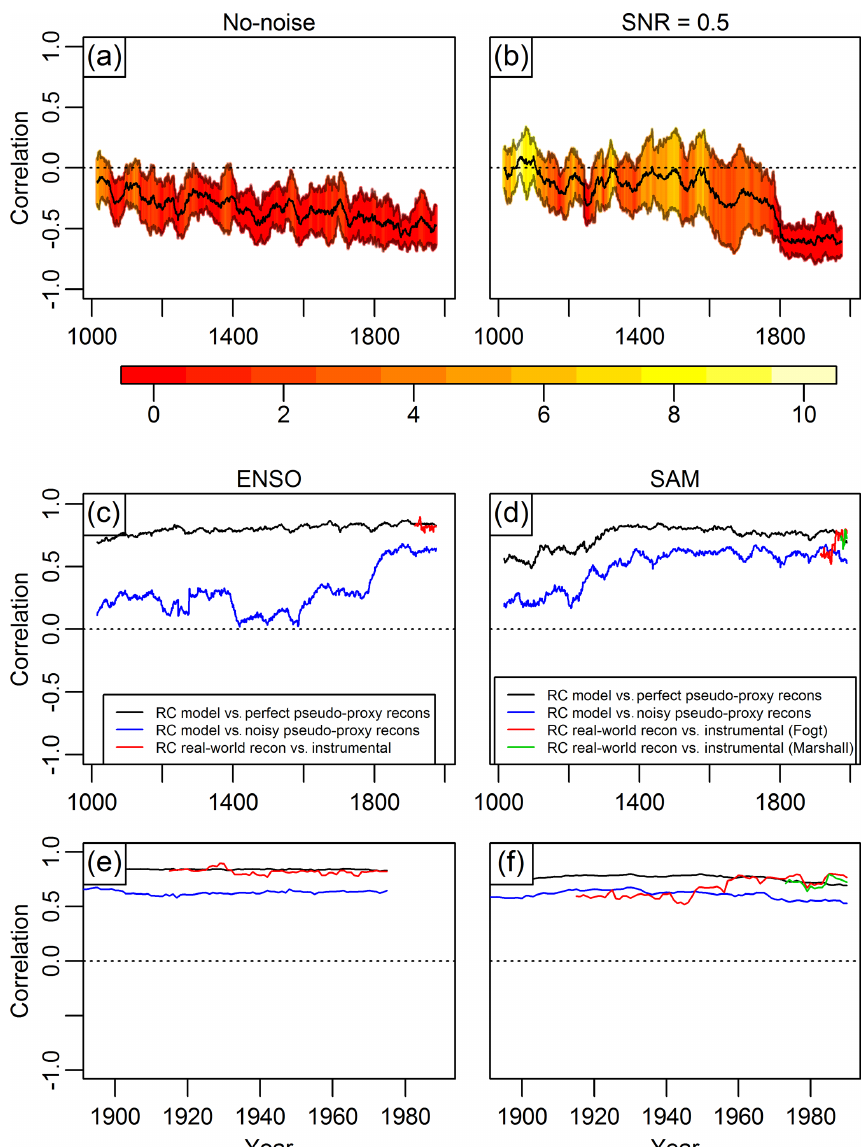
Figure 3. Panel (a) shows the mean of the 31-year running correlations over all 13 models between the perfect pseudo-proxy-based ENSO and SAM reconstructions. Panel (b) shows the same as panel (a) but using the noisy pseudo-proxy-based ENSO and SAM reconstructions. The grey lines correspond to ± 1 standard deviation. Panel (c) displays in black (blue) the mean 31-year running correlations over the 13 models between the model ENSO index and the perfect (noisy) pseudo-proxy-based ENSO reconstructions. The red line shows the 31-year running correlations between the real-world proxy-records-based ENSO reconstruction and the instrumental ENSO index. Panel (d) is the analogue of panel (c) but for the SAM. The red (green) line displays the 31-year running correlations between the real-world proxy-records- based SAM reconstruction and the instrumental Fogt (Marshall) SAM index. Panels (e) and (f) are enlargements of panels (c) and (d) over the 20th century. The red to yellow shading in panels (a) and (b) indicates, for each year, the number of running correlations among the individual 13 models that show a positive (reversed)